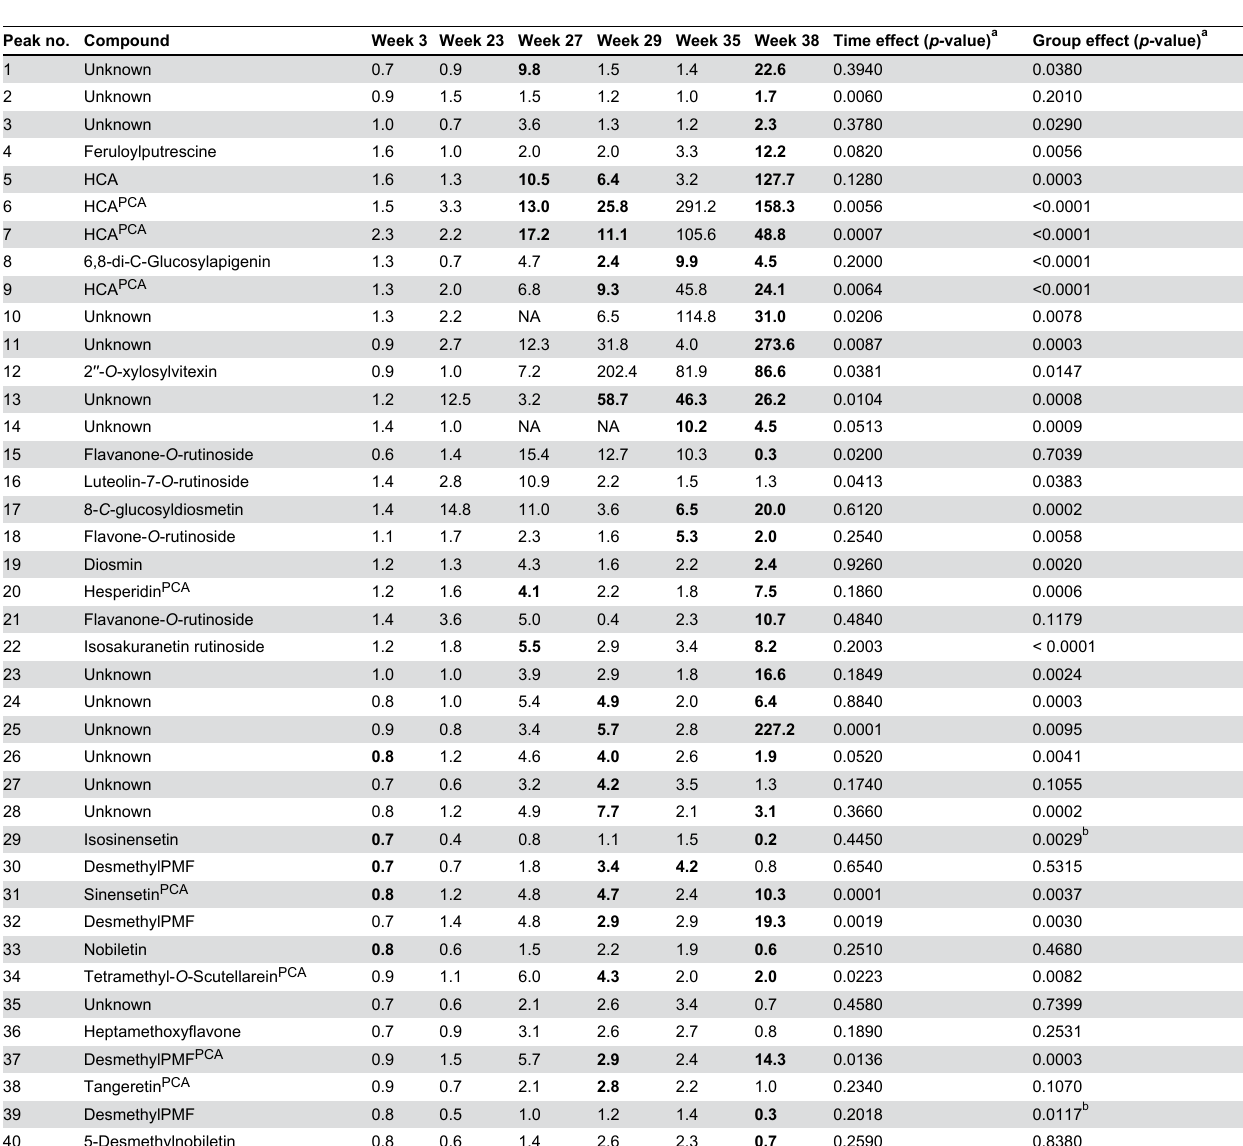
Table 5. The relative amounts of metabolites from leaves of C Las-inoculated ‘Valencia’ trees with respect to control ‘Valencia’